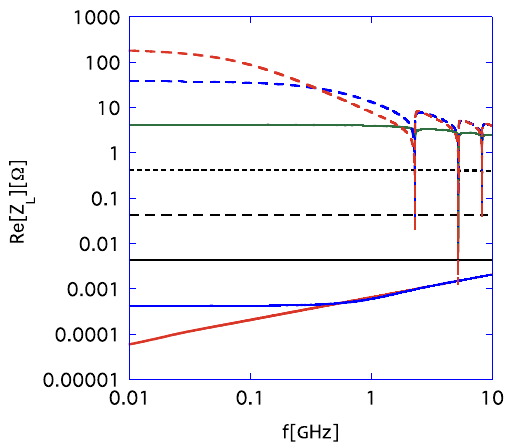
4. (Color) The thickness dependence of the longitudinal impedance of the insert in the relativistic beam case. The red, the blue, the black, the black dashed, the black dot, the green, and the blue dashed and the red dashed lines represent the cases that thickness t is equal to 100 (cid:13) m , 10 (cid:13) m , 1 (cid:13) m , 100 nm, 10 nm, 1 nm, 100 pm, and 10 pm, respectively. The matching point is z ¼ 0 .